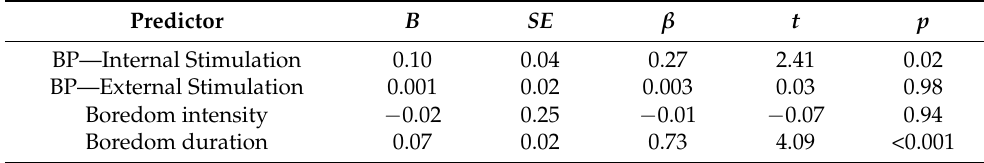
Table 3. Regression analysis of the association between boredom frequency and other boredom experiences.